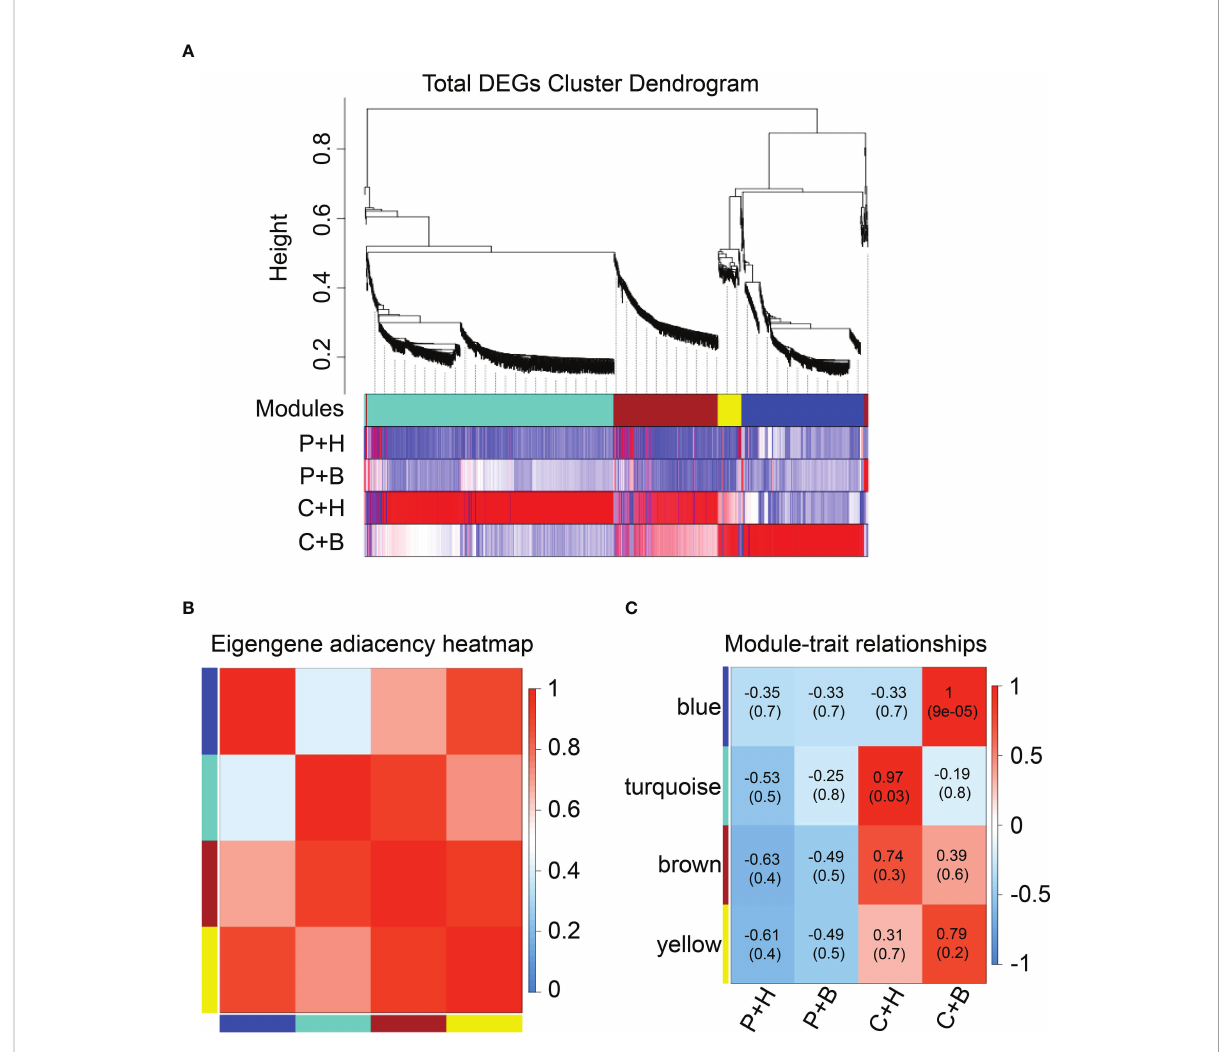
FIGURE 4 Weighted correlation network analysis (WGCNA) of DEGs. (A) Hierarchical cluster tree and heatmap of all DEGs. The hierarchical cluster tree shows co-expression modules identi fi ed through WGCNA. Each leaf in the tree represents one DEG. The major tree branches constitute four modules labelled with different colors. The heatmap shows the relative expressions of the whole DEGs in different modules. (B) Eigengene adjacency heatmap of the four modules shows the correlations among different modules. The darker red represents a higher correlation. (C) Associations between modules and traits. The colors of the modules are the same as that shown in (a) and (b) . The numbers in individual cells represent the correlations and the P values. P+H, PBS solution + H 2 O; P+B, PBS, PBS solution + boron; C+H, CGMMV + H 2 O; C+B, CGMMV +